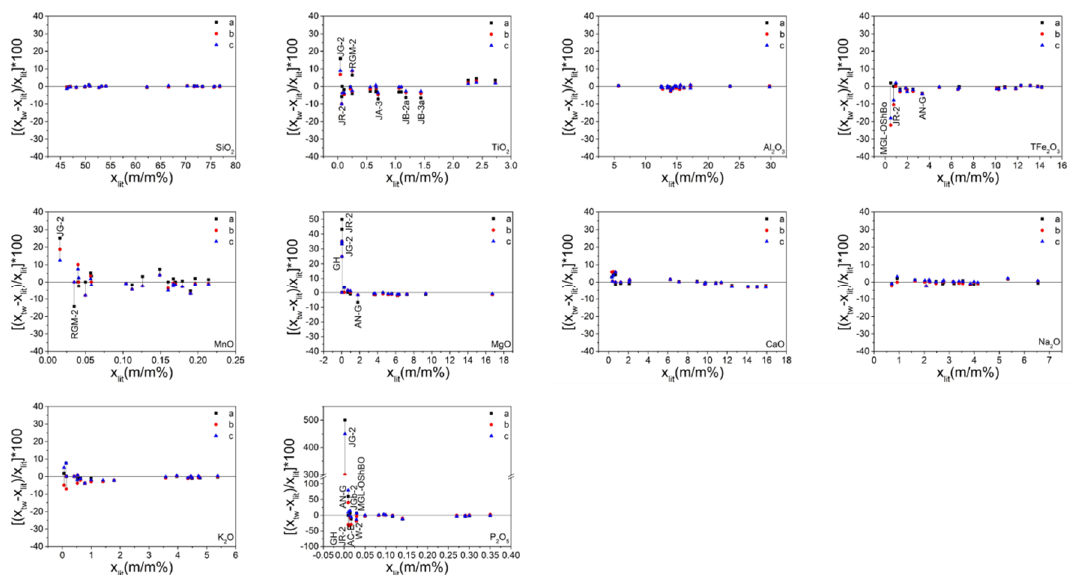
Figure 5. Representation of the relative errors of the measured values for the major elements (letters